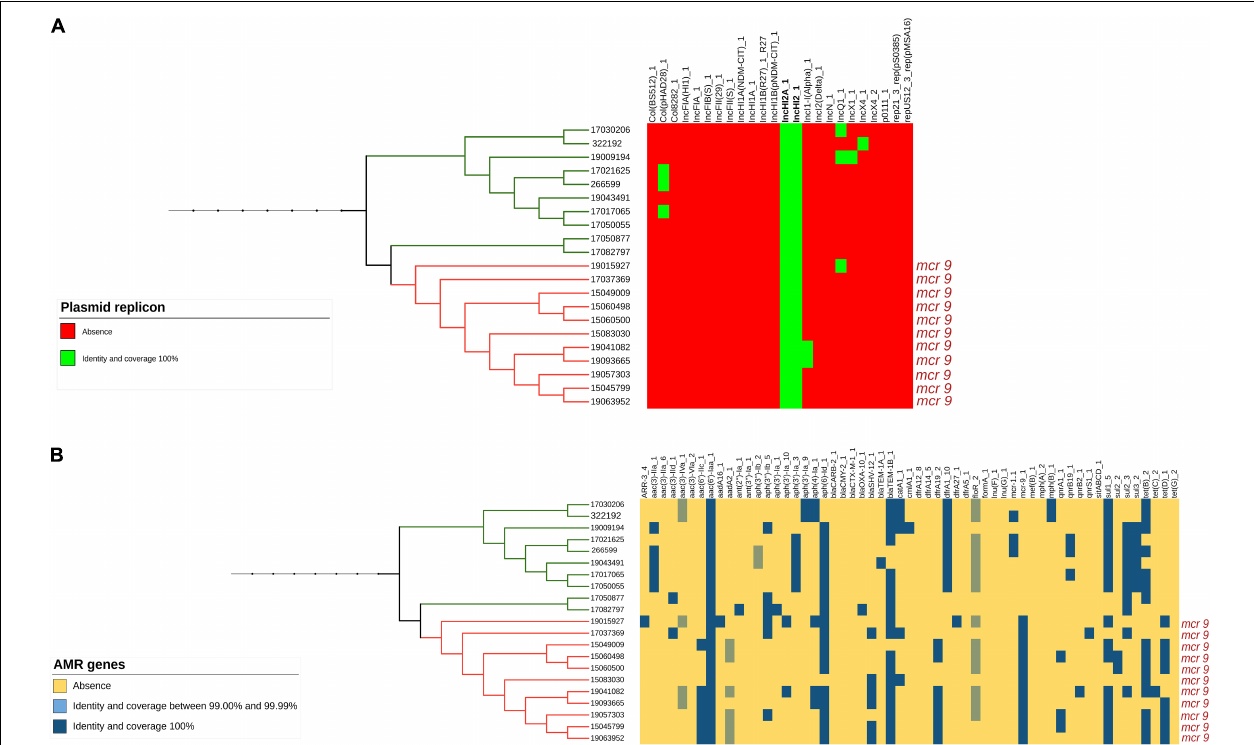
FIGURE 2 | (A) Presence or absence of plasmid replicons identified by Mash analysis in the mcr-9-positive and related mcr-9-negative isolates. (B) Presence or absence of AMR genes identified by Mash analysis in the mcr-9-positive and related mcr-9-negative isolates.